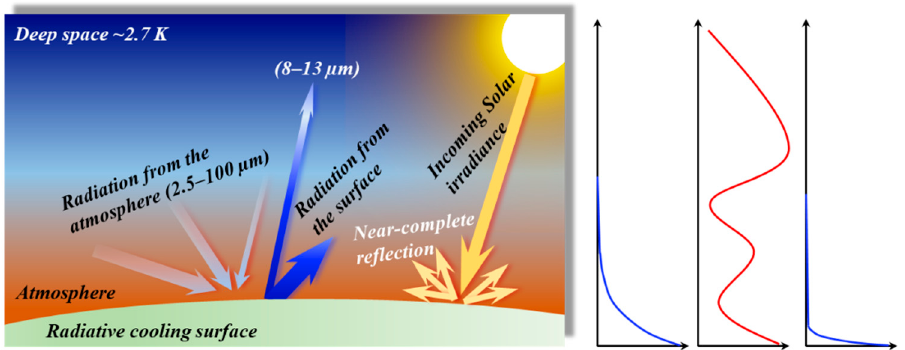
Figure 1. A schematic of radiative heat exchanges between a sky-facing radiative cooling surface and the atmosphere. On the right is the illustration of a complex set of atmospheric profiles, showing the altitude-dependence of various properties such as pressure, temperature, and water vapor. The surface absorbs longwave radiation coming from all altitudes of the atmosphere, with the lowest atmospheric layer being the dominant source. Longwave radiation emitted by the surface is mostly trapped by the atmosphere, with only a fraction reaching the deep space mainly through the atmospheric window (8–13 µm).